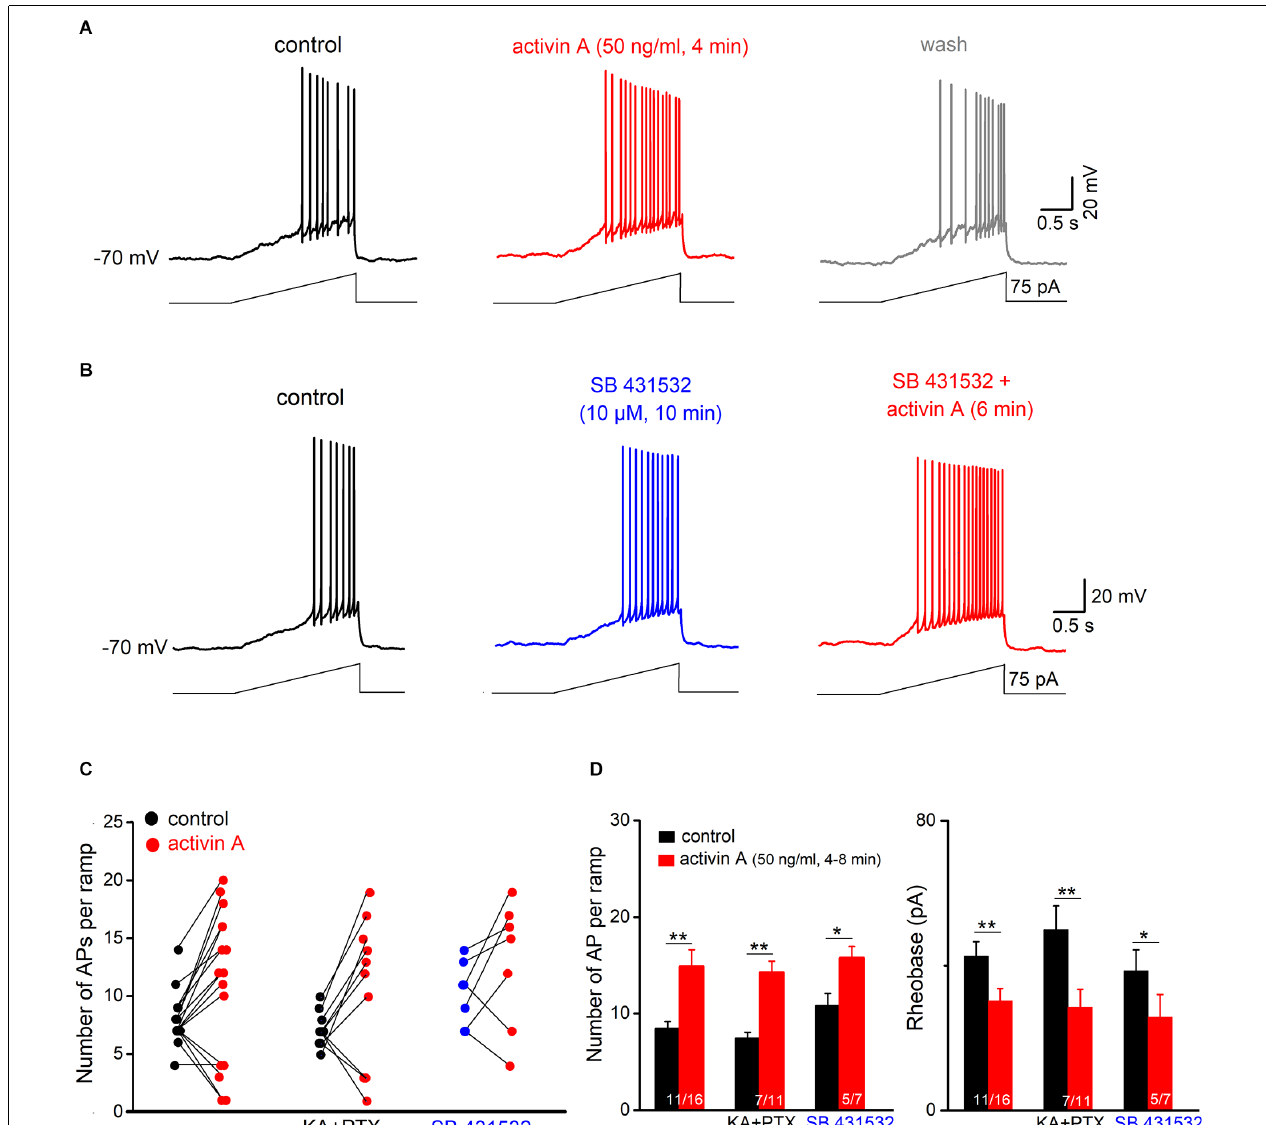
FIGURE 3 | Activin A excites hippocampal granule cells on a fast time scale. A depolarizing ramp (rising from 0 to 50–100 pA within 2 s) was used to test the acute effect of activin A on AP firing in wt granule cells (initially held at -70 mV). (A) Voltage traces illustrate the reversible effect of briefly applied activin A (50 ng/ml, 4 min) on granule cell firing. (B) Representative traces from a wt slice in which activin A was administered in the presence of SB 431532 (10 µ M). (C) Summary of granule cell responses to brief application of activin A in control solution (left), in the presence of blockers of GABA A receptors (picrotoxin; PTX) and ionotropic glutamate receptors (kynurenic acid, KA) (middle), and in the presence of SB 431532 (right). (D) Histograms summarize enhanced firing and reduced rheobase (the minimal current to evoke first AP) in all granule cells excited by activin A. * p < 0.05, ** p <